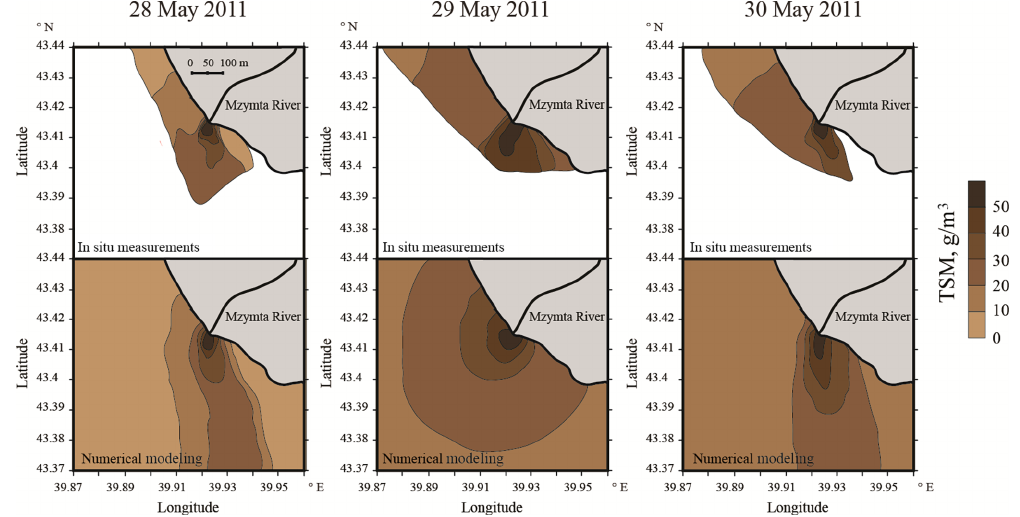
Figure 9. Measured (top panel) and modeled (bottom panel) surface TSM distributions near the Mzymta River estuary on 28–30 May 2011.